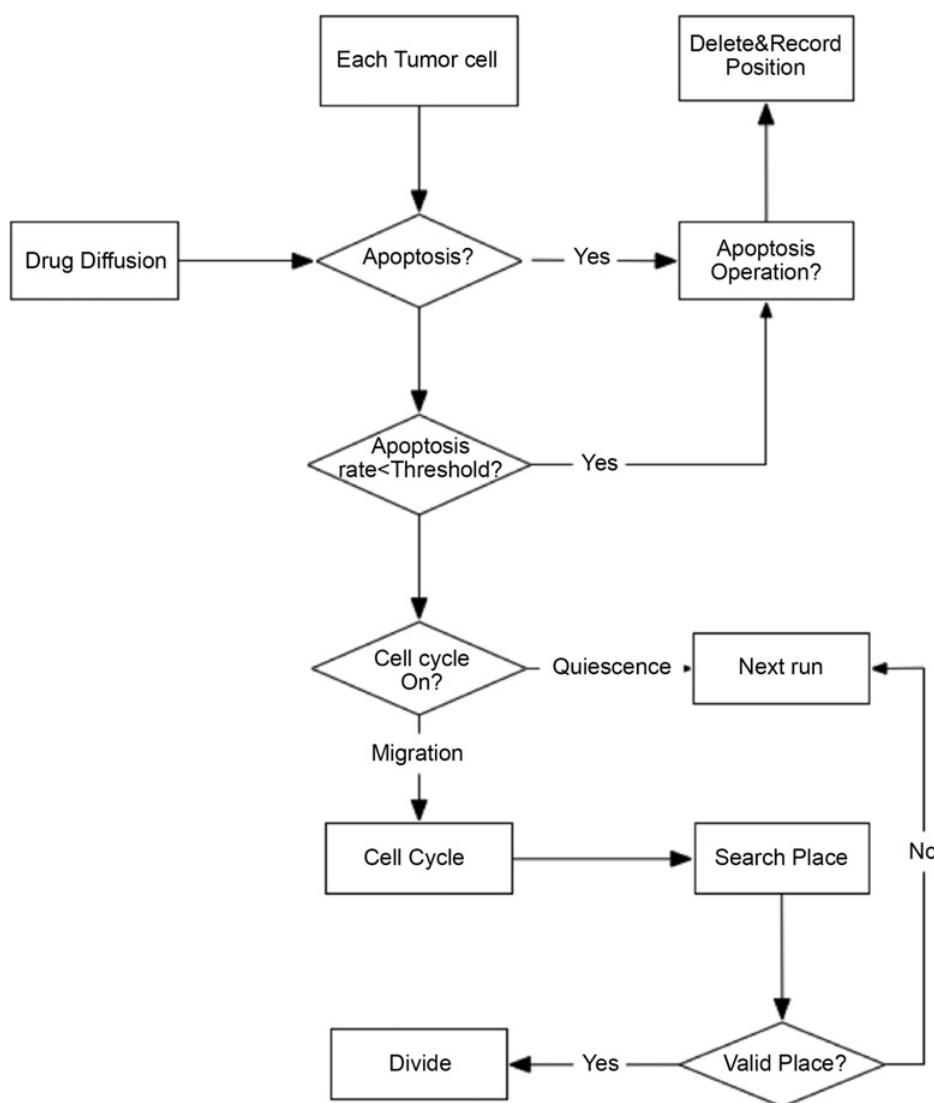
Fig 2. A flow chart of cellular phenotype switching at the intracellular scale. Apoptosis: At each time step, if the apoptosis probability of the cell (OBs, OCs or MMs) is less than the threshold, Apop rate , the cell will initiate apoptosis. Proliferation : The proliferation of each cell is influence by cytokines from other cells. Migration: A proliferating cell will migrate in the first three phases of cell cycle (G0/G1, S and G2), whereas it will look for an empty location to divide after entering the mitotic M phase. Quiescence: There are two possibilities for the cell to be in a quiescent state: the cell cannot go through the cell cycle, or the cell cannot find an appropriate free location for